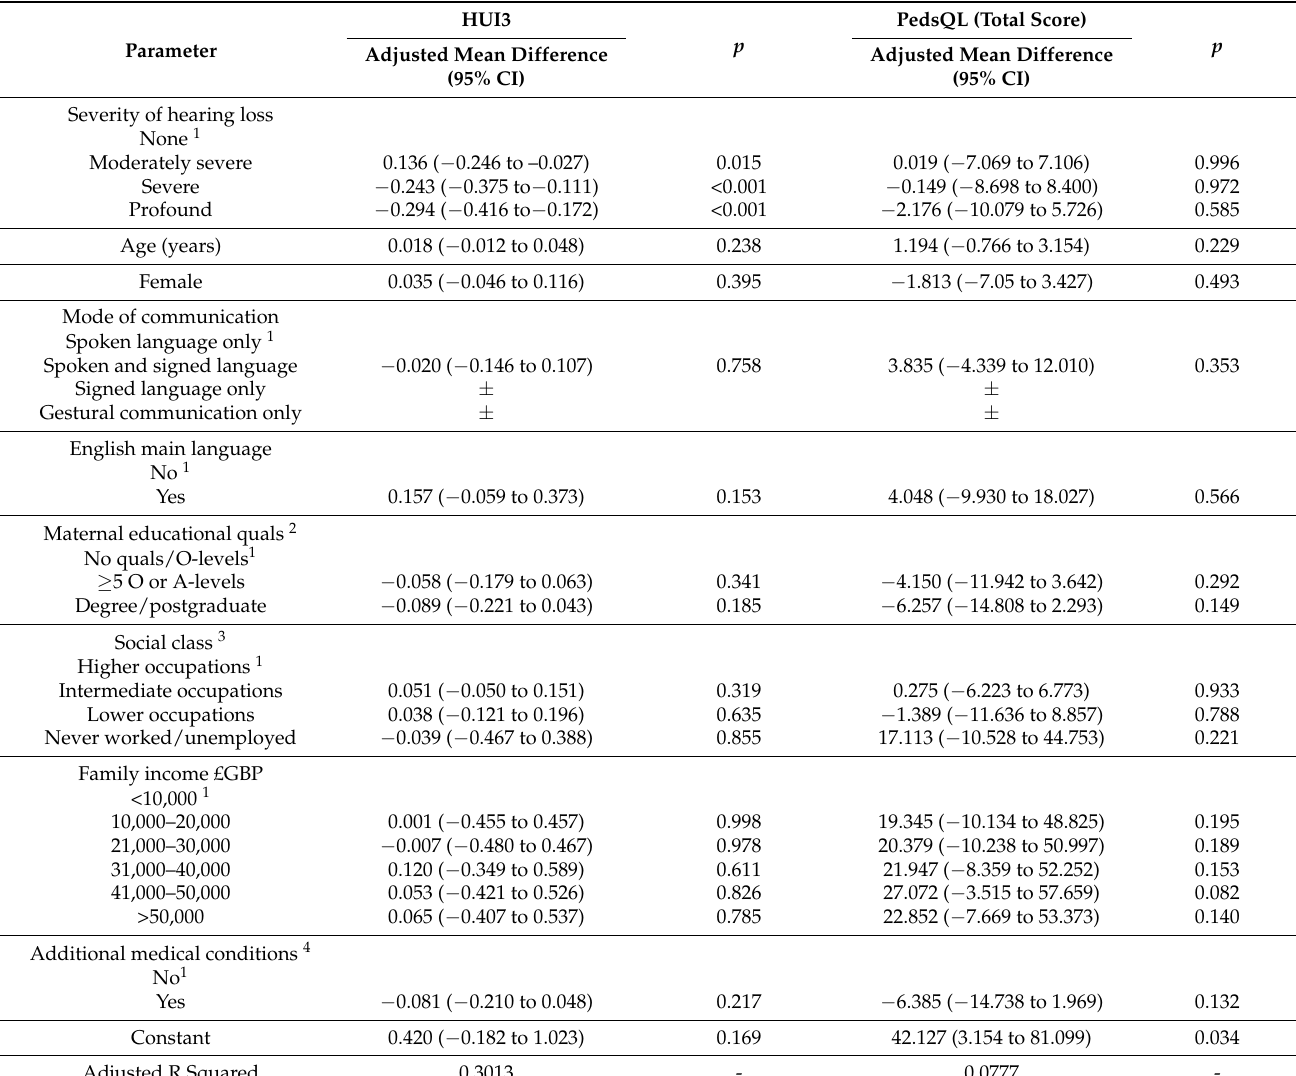
Table 4. Multivariable analyses of self-reported HRQoL outcomes in relation to severity of hearing loss (OLS regression, fully specified).